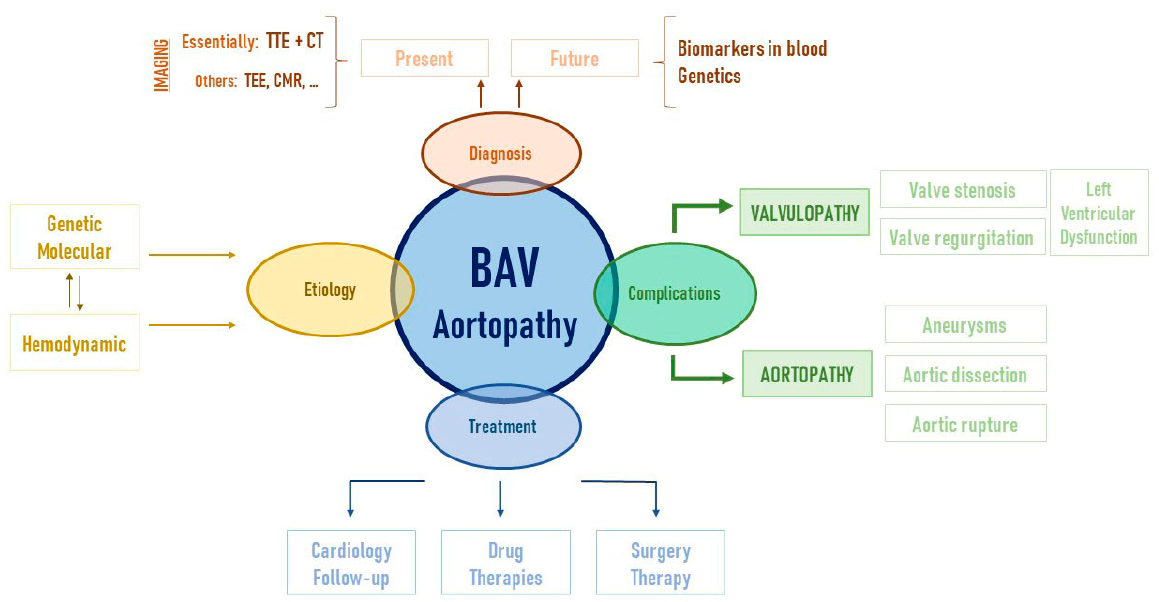
Figure 3. Bicuspid aortopathy is a complex syndrome that includes many parts. Translational research is essential, from the laboratory to daily medical practice, in order to address not only each piece (etiology, diagnostic methods, complications, and treatment) but also the whole problem. In this way, each step that improves scientific knowledge in bicuspid aortopathy improves the lives of the patients who suffer from it. TTE: transthoracic echocardiography; CT: computed tomography; TEE: transesophageal echocardiography; CMR: cardiac magnetic resonance.